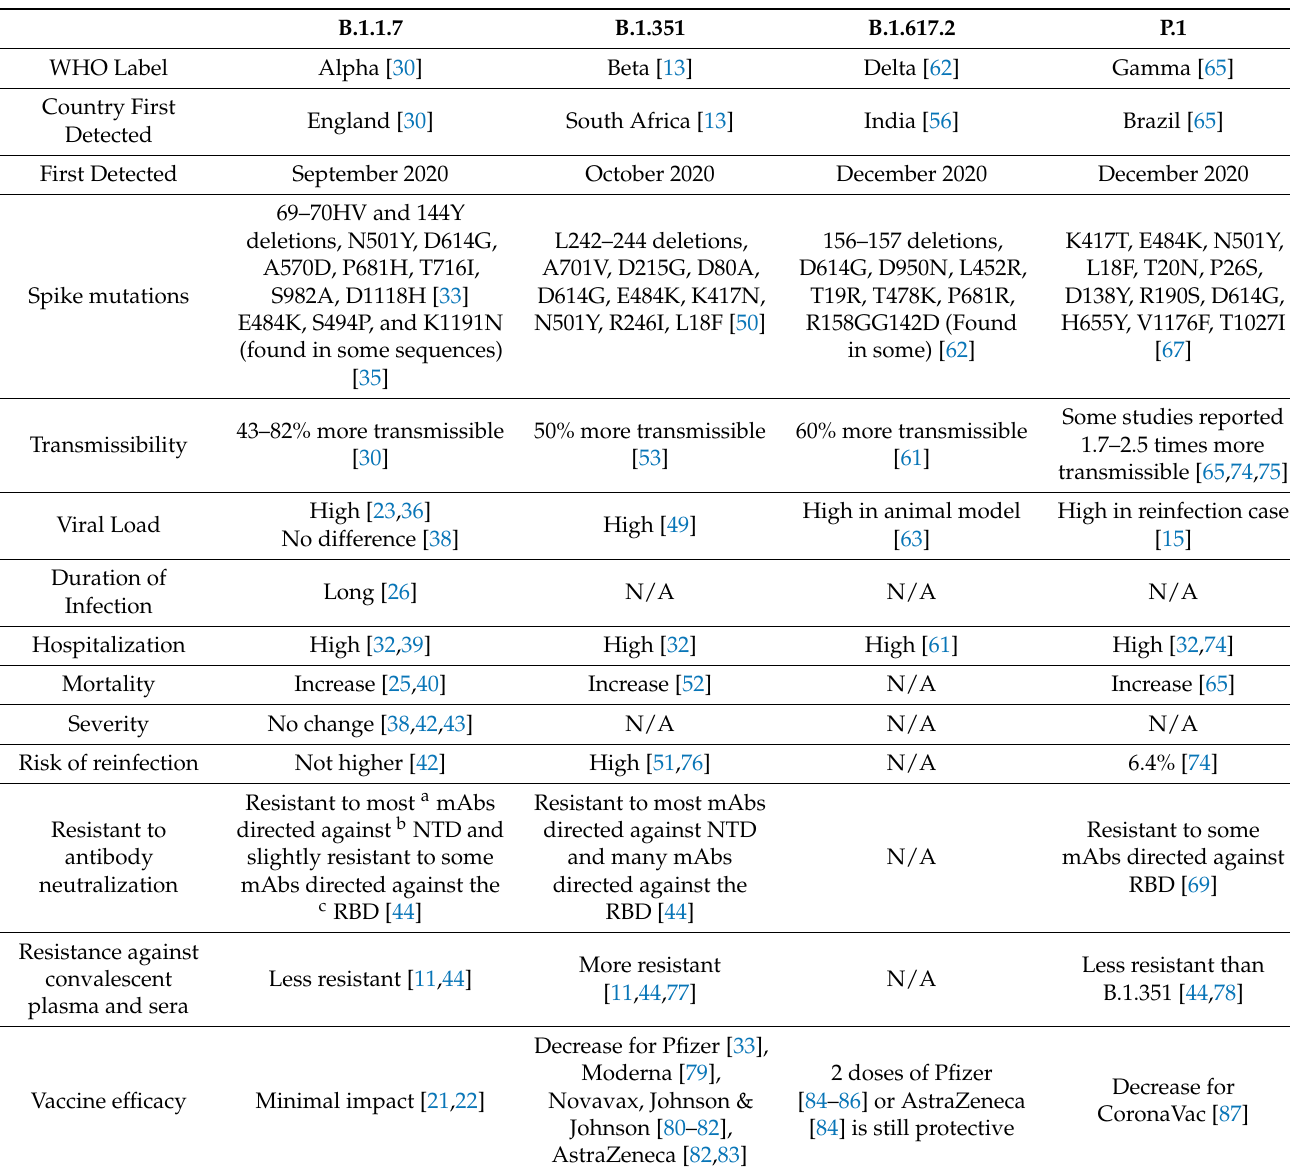
Table 1. A summary of the characteristics of variants of concern